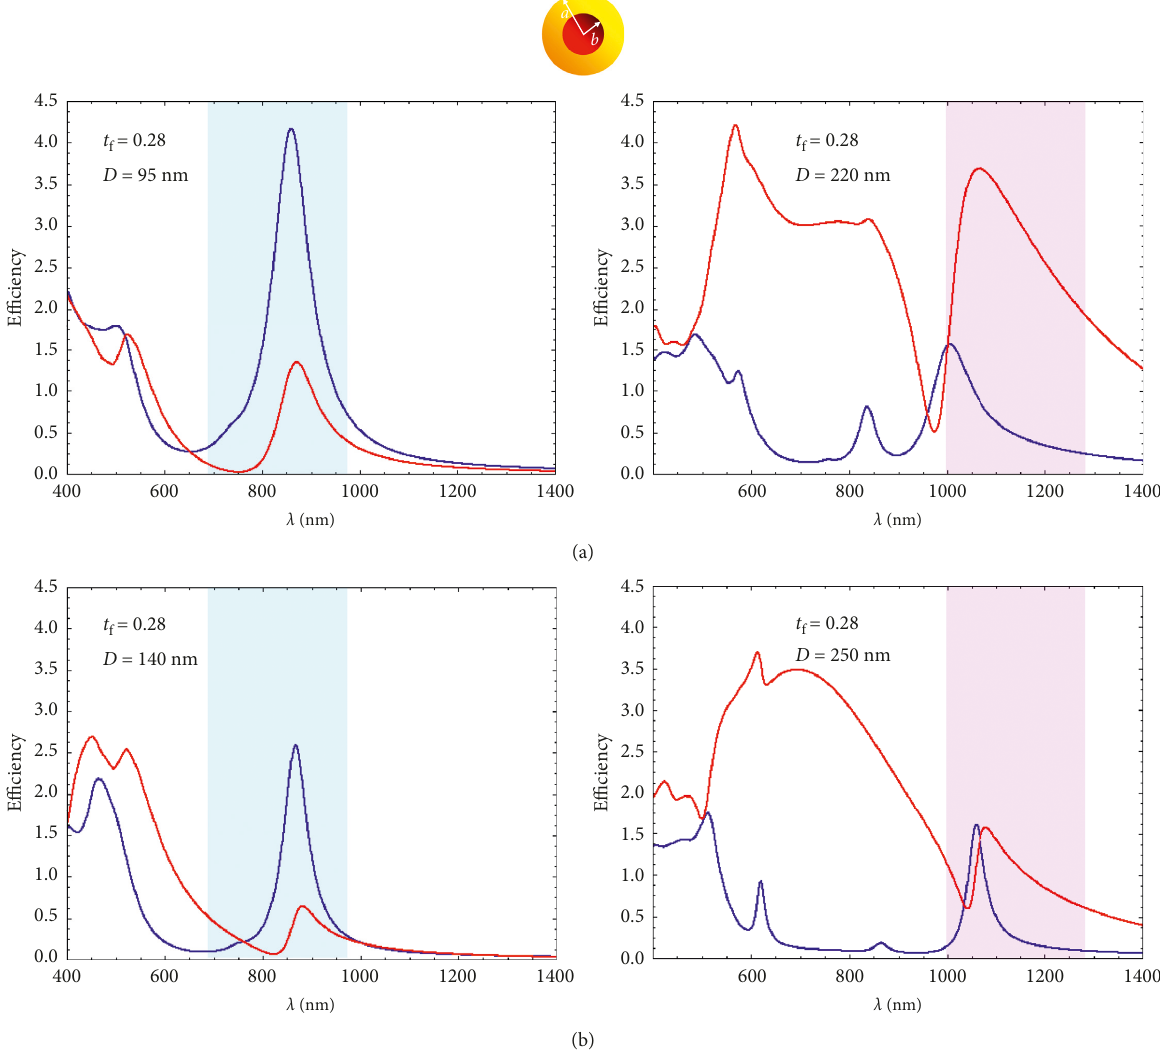
Figure 4: The absorption efficiency Q abs (blue line) and scattering efficiency Q sca (red line) of a single Si/Au nanoshell in biological tissues (a) and in vacuum (b) as a function of the incident light wavelength λ for selected nanoparticle diameters and a shell thickness fraction t � 0 . f